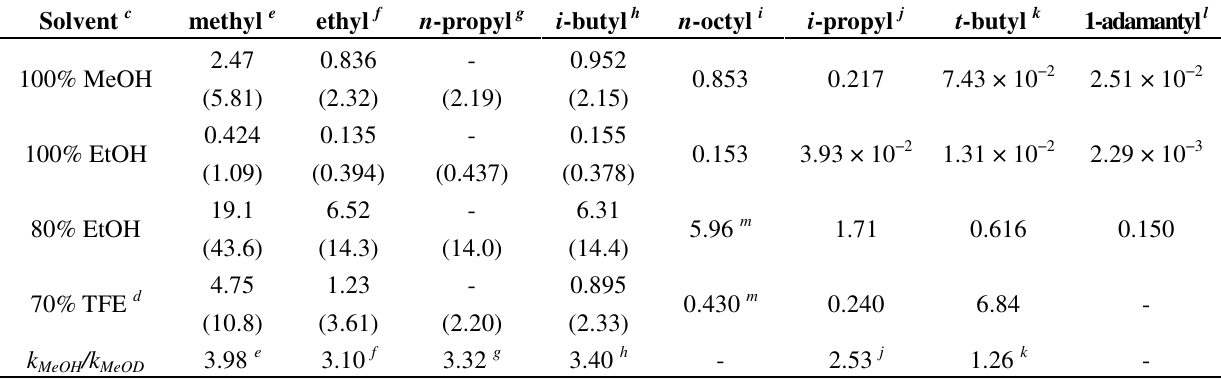
Table 4. A comparison of the specific rates (10 4 k (s −1 )) a , b of solvolysis of several alkyl fluoroformates (ROCOF) in pure and binary solvents at 25.0 °C , and the solvent isotope effect values ( k / k MeOH MeOD